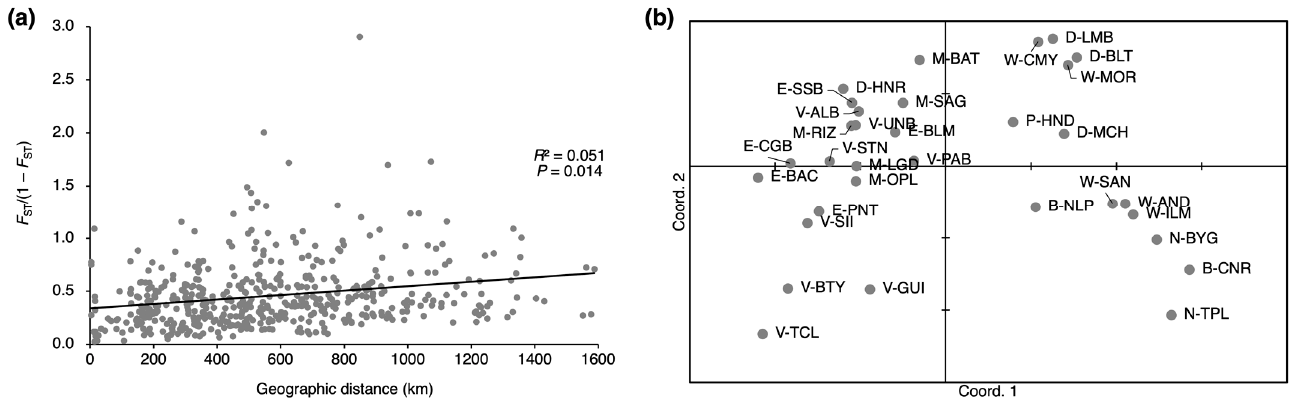
Table 2. Analysis of molecular variance (AMOVA) showing degrees of freedom (d.f.), sum of squares (SS), variance component (Variance), percentage of variance (%) and F-statistic among sites. Source d.f. F -Statistic p Value Among sites Within sites P-PPB was removed due to low sample size with a large number of clonal replicates ( N MLG = 4, R = 0.07).